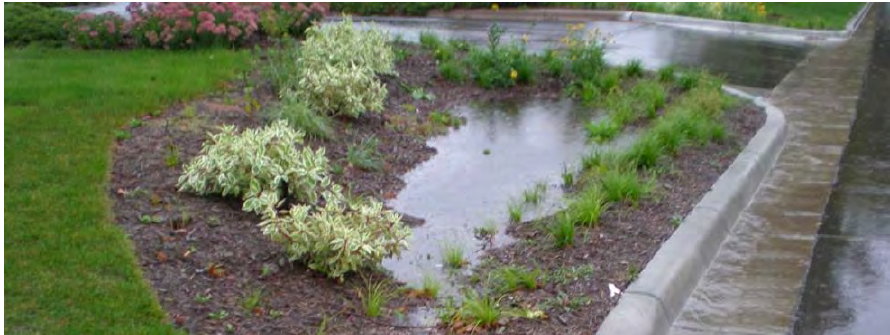
Fig. 11: Rain gardens in University of Minnesota. ( Minnesota,